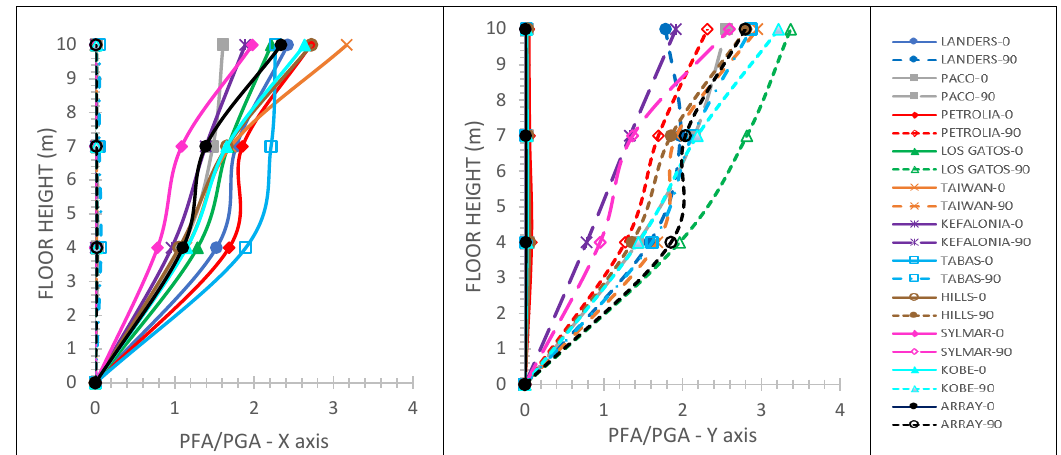
fixed connection of the steel structure to the r/c one.